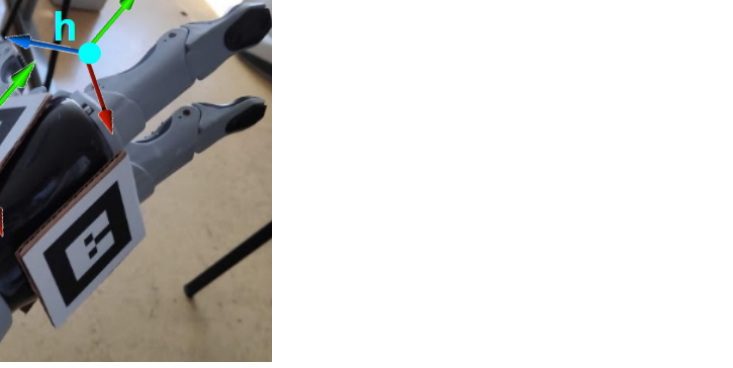
Figure 5. End-effector localization through ALVAR tags (M: marker pose, h: hand pose).